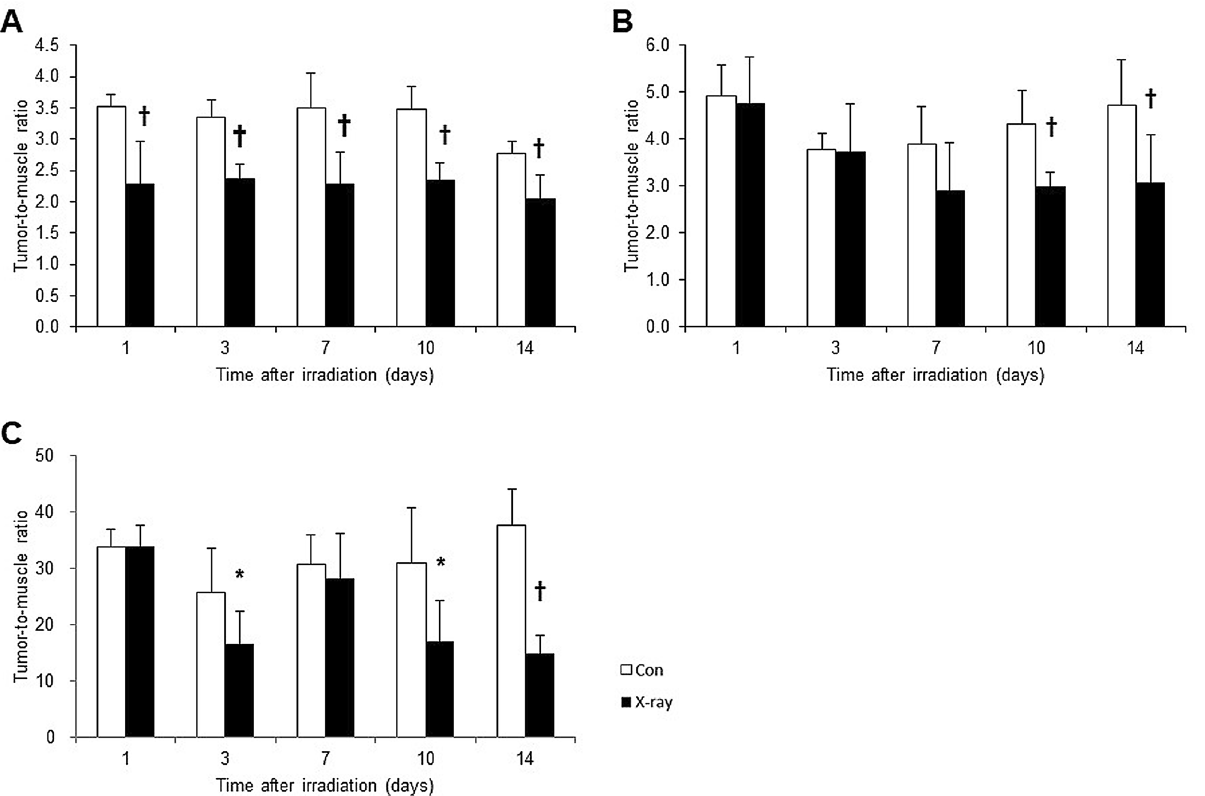
Figure 6. Change in probe uptake of LNZ308 tumors after irradiation. Tumors on right paws were irradiated on day 0 at the dose of 60 Gy. Probe uptake studies were performed at days 1, 3, 7, 10, and 14 after irradiation. Uptake of [ 18 F]FIMP ( A ), [ 11 C]MET ( B ), and [ 18 F]FDG ( C ) were denoted by the tumor-to-muscle ratio (TMR). Each point represents mean ± SD (n = 4–8). * p < 0.05 and † p < 0.01, as compared with